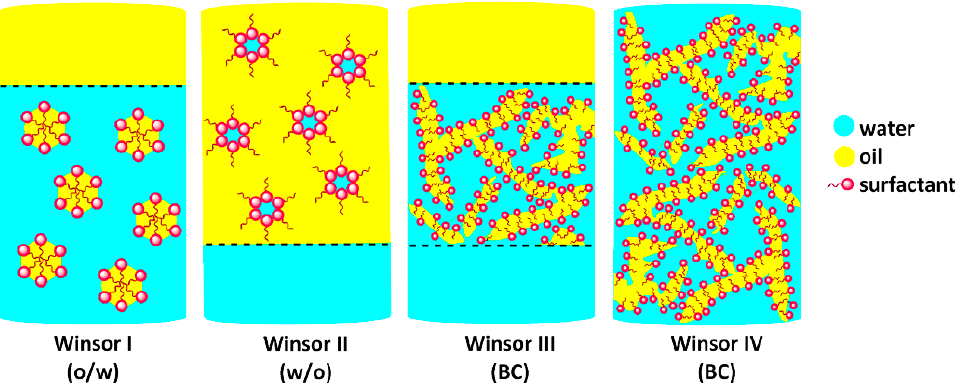
Figure 19. Types of microemulsions according to Windsor. Water and oil phases are colored in turquoise and yellow color, respectively. W, O and BC refer to water, oil and bicontinuous phase, respectively [3]. Reprinted with permission from ref. [3]. Copright 2021